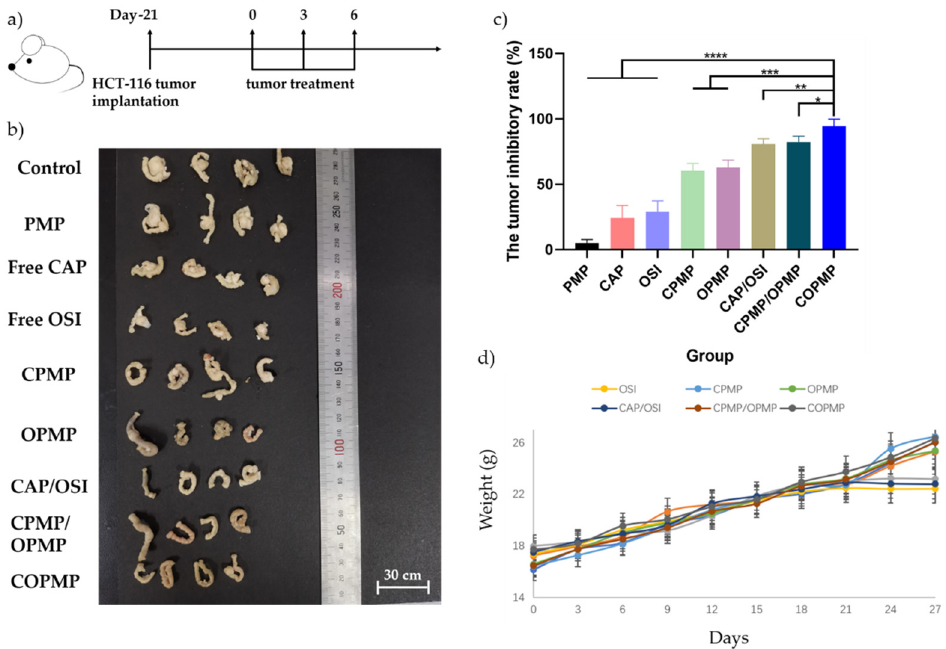
Figure 4. Therapeutic antitumor efficacy in an HCT-116 tumor model. ( a ) Schematic timeline of the efficacy study. Tumors were treated with normal saline, PMP, free CAP, free OSI, CPMP, OPMP, CAP/OSI, CPMP/OPMP, or COPMP ( n = 4, mean ± SD); ( b ) tumor sizes for each group after treatment; ( c ) tumor inhibitory rates for each group after treatment; ( d ) body weight of mice after treatment ( n = 4, mean ± SD). * p < 0.05, ** p < 0.01, *** p < 0.001, **** p < 0.0001.